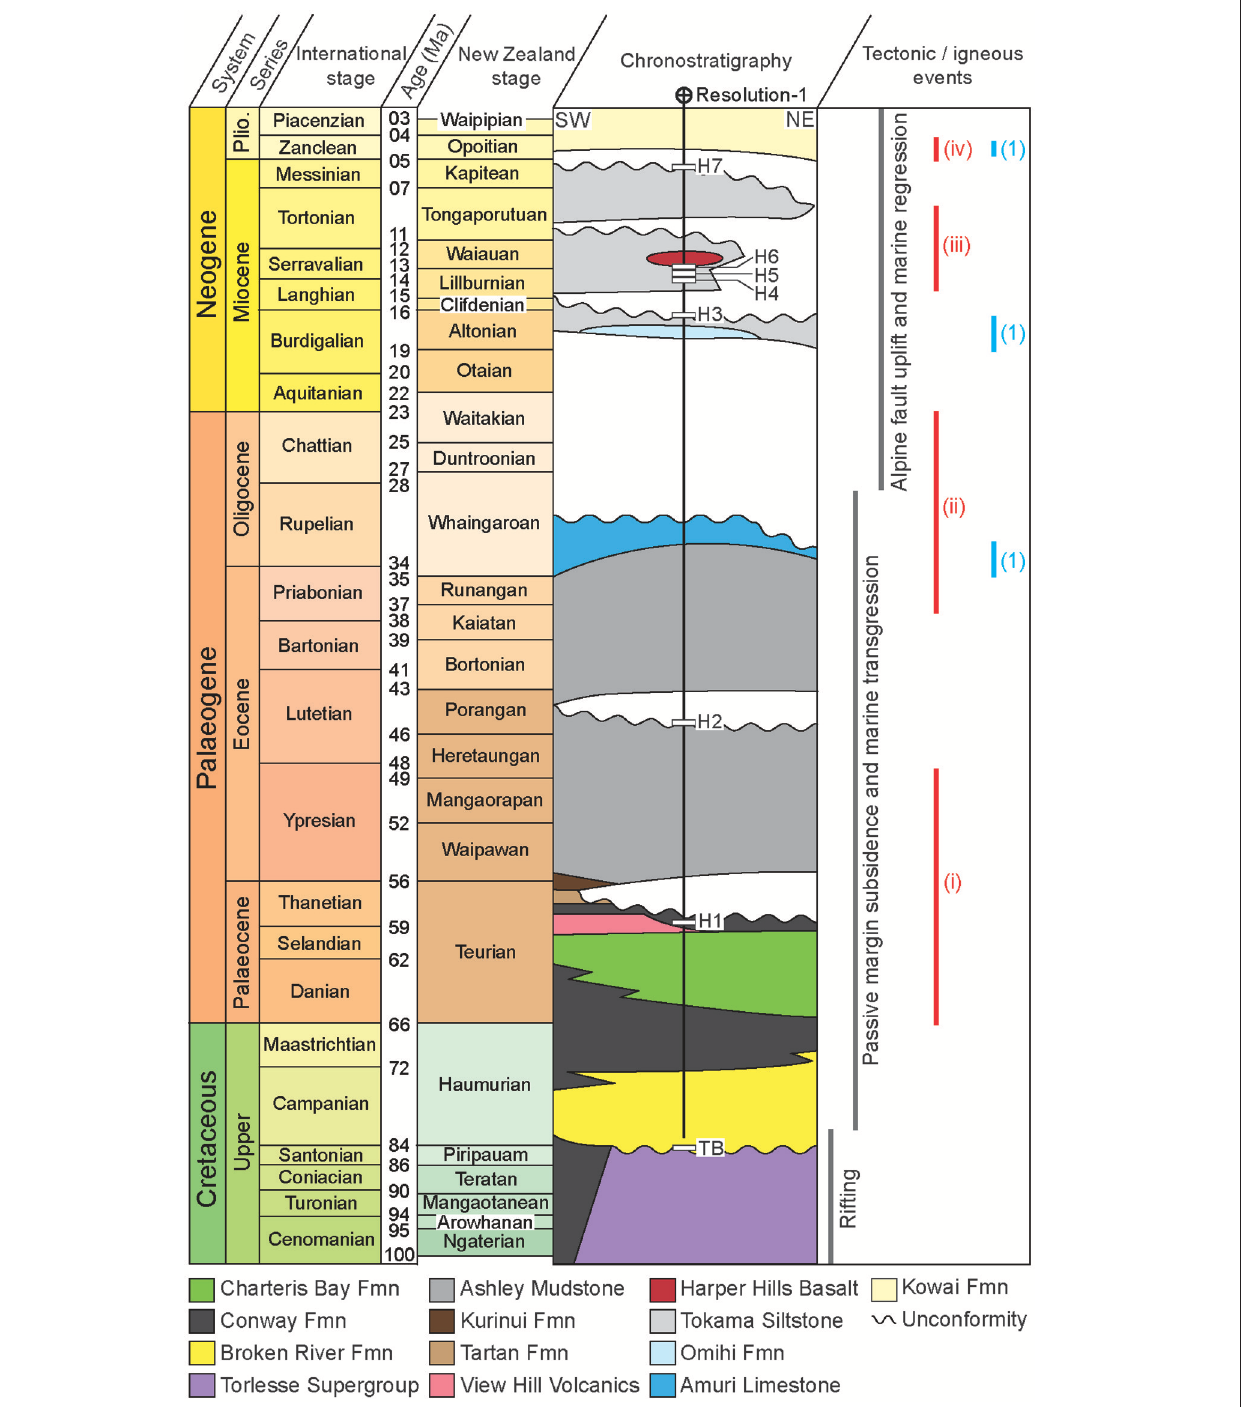
FIGURE 3 | Chronostratigraphic chart for the northern Canterbury Basin around Resolution-1, highlighting different tectonic and igneous events (based on Carter, 1988; Fulthorpe et al., 1996; Killops et al., 1997; Timm et al., 2010; Uruski, 2010; Schiøler et al., 2011; Reeves et al., 2018 ). Igneous events from Timm et al. (2010) correspond to: (i) Geraldine and Timaru Lavas; (ii) Banks Peninsula; (iii) Cookson Volcanics; (iv) View Hill, Central Canterbury. (1) Offshore sill emplacement events (Reeves et al., 2018). Fmn, formation.